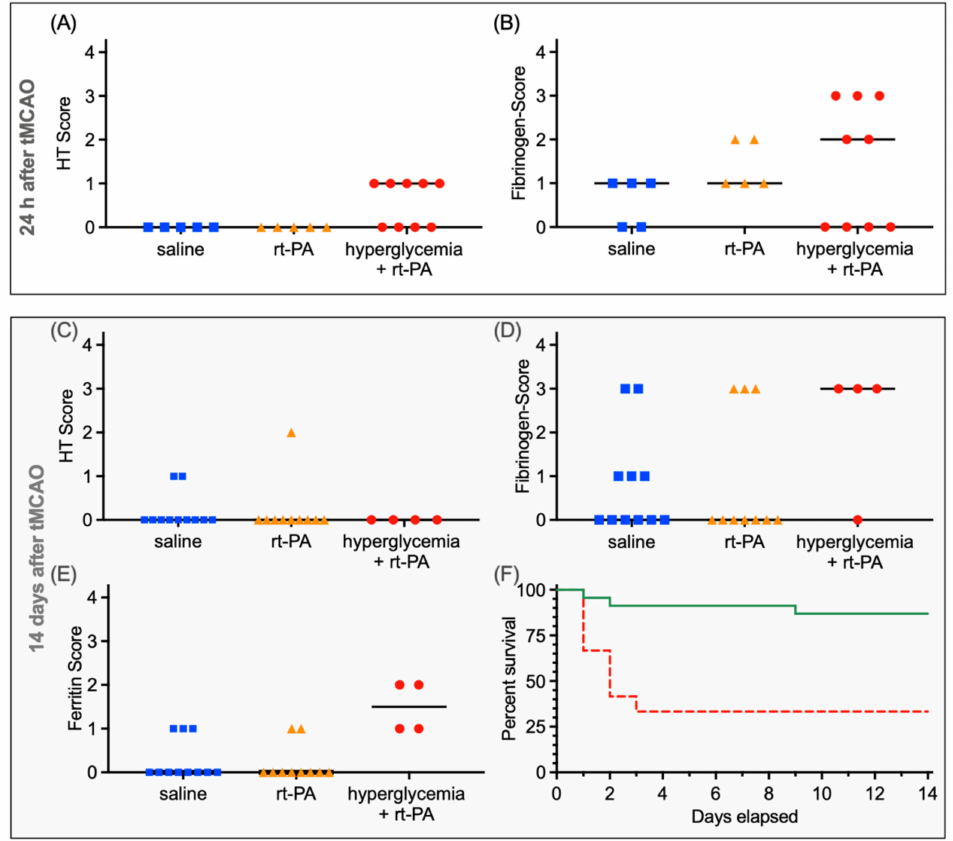
Figure 3. Extent of hemorrhagic transformation (HT) and blood–brain barrier (BBB) dysfunction . ( A ) At 24 h after rt-PA or saline treatment, the HT score differed significantly ( p = 0.02), with the highest scores within the hyperglycemia + rt-PA group. Additionally, no significant difference in HT could be measured in photometric hemoglobin assay (saline vs. rt-PA p > 0.99). ( B ) Fibrinogen extravasation, reflecting the extent of BBB dysfunction, reached the highest values in the hyperglycemia + rt-PA group ( p = 0.38). ( C ) Concerning treatment, 14 days after tMCAO the HT scores did not differ significantly ( p = 0.66). ( D ) Fibrinogen extravasation 14 days after tMCAO did not differ significantly ( p = 0.24). The same applies for IgG staining (data not depicted). ( E ) Nevertheless, iron staining was scored significantly higher in hyperglycemic mice ( p < 0.01). ( F ) Mortality of mice in the 14 days substudy is illustrated in a Kaplan–Meier survival curve (red = hyperglycemic animals; green = normoglycemic animals). Importantly, due to the high mortality in the hyperglycemic group, only 4 animals could be analyzed (Hazard Ratio 11.61, CI